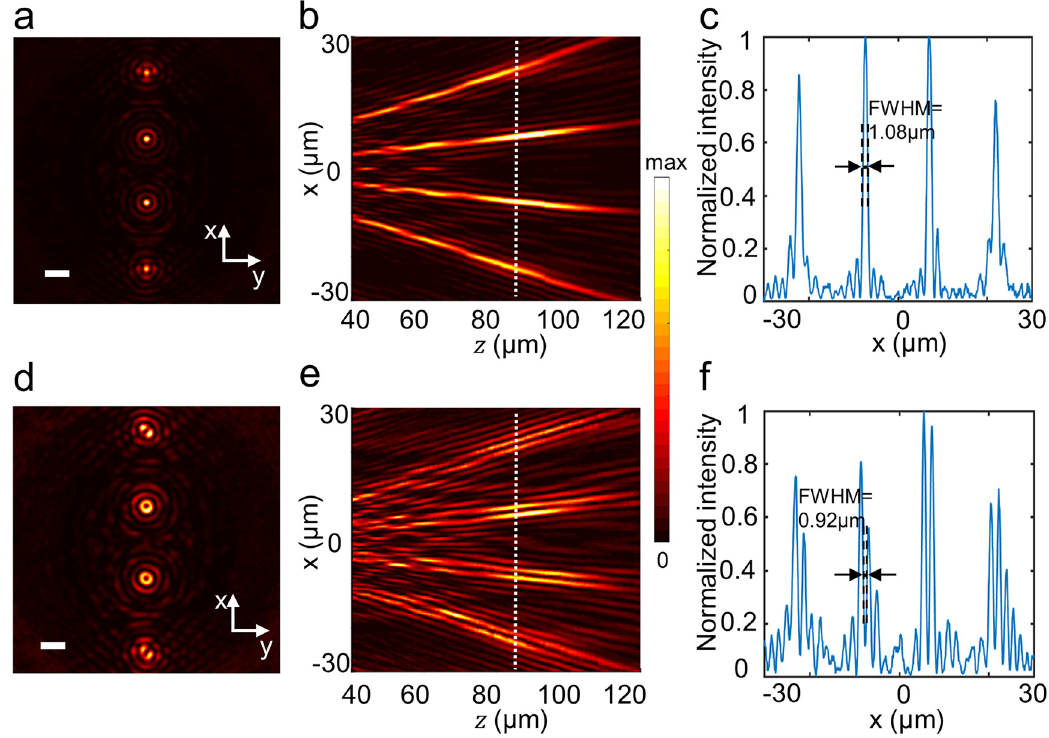
Figure3: LightfielddistributionofBesselbeamarraywithNA=0.2atthedesignatedwavelength λ d =630nm.Measuredtransverseintensity distributionsof1 × 4arraysof(a) J 0 Besselbeamsand(d) J 1 Besselbeams,Scalebar=10µm.Measuredlongitudinalintensitydistributionsof1 × 4 arrays of (b) J fi les from (b) and 0 Bessel beams and (e) J 1 Bessel beams. (c) and (f) are the extracted pro